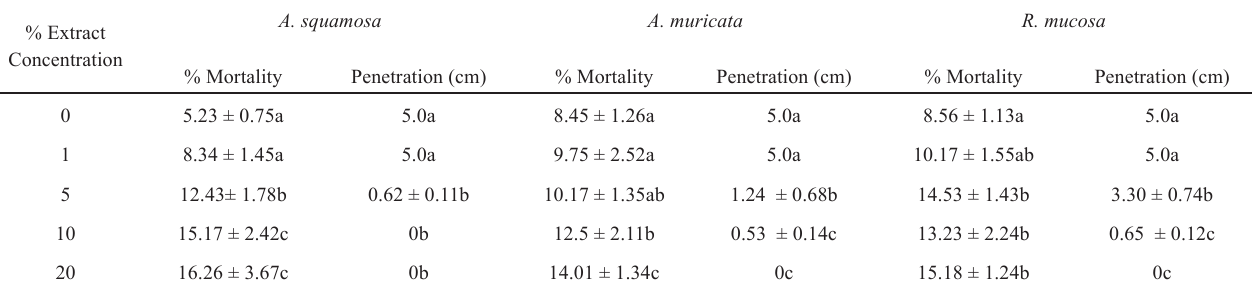
Table 2 . Average mortality and penetration distance of C. gestroi after 7 days in tunneling tubes containing soil treated with various concentration of Annona seed